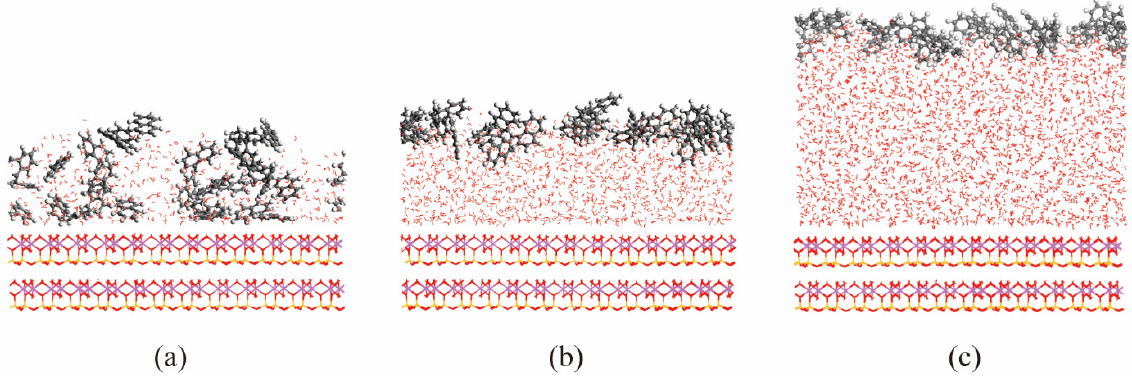
Figure 12. The equilibrium configuration of ternary models under the different thicknesses of the aqueous layer. ( a ) 5 Å ; ( b ) 10 Å ; ( c ) 15 Å .